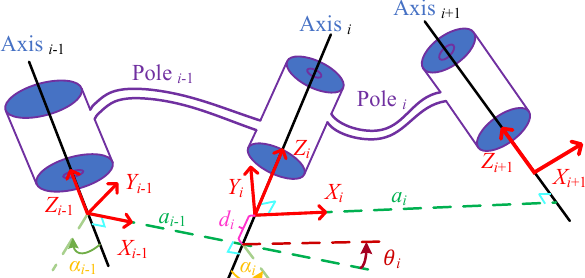
Figure 11. D-H coordinate system diagram.